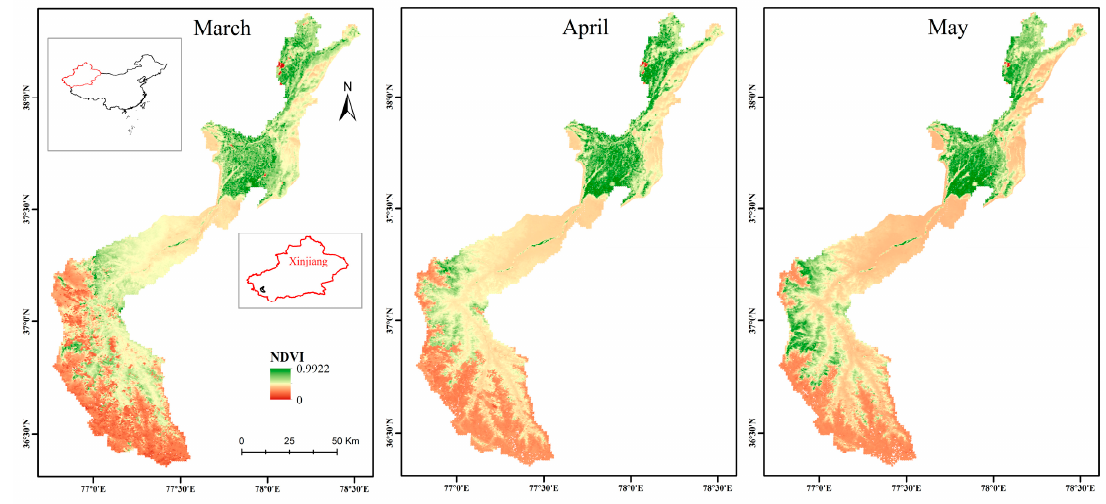
Figure 6. Springtime NDVI distribution in the research area.